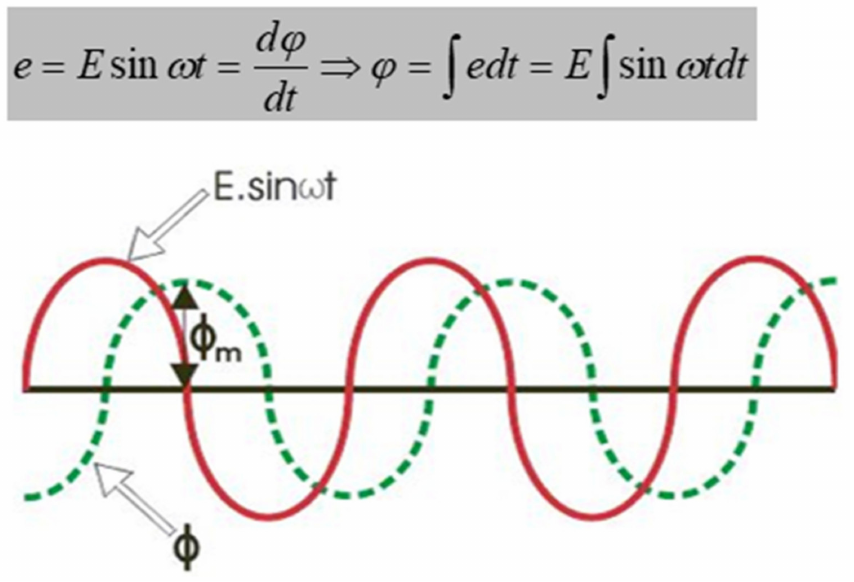
Figure 5. Calculation of the induced emf.